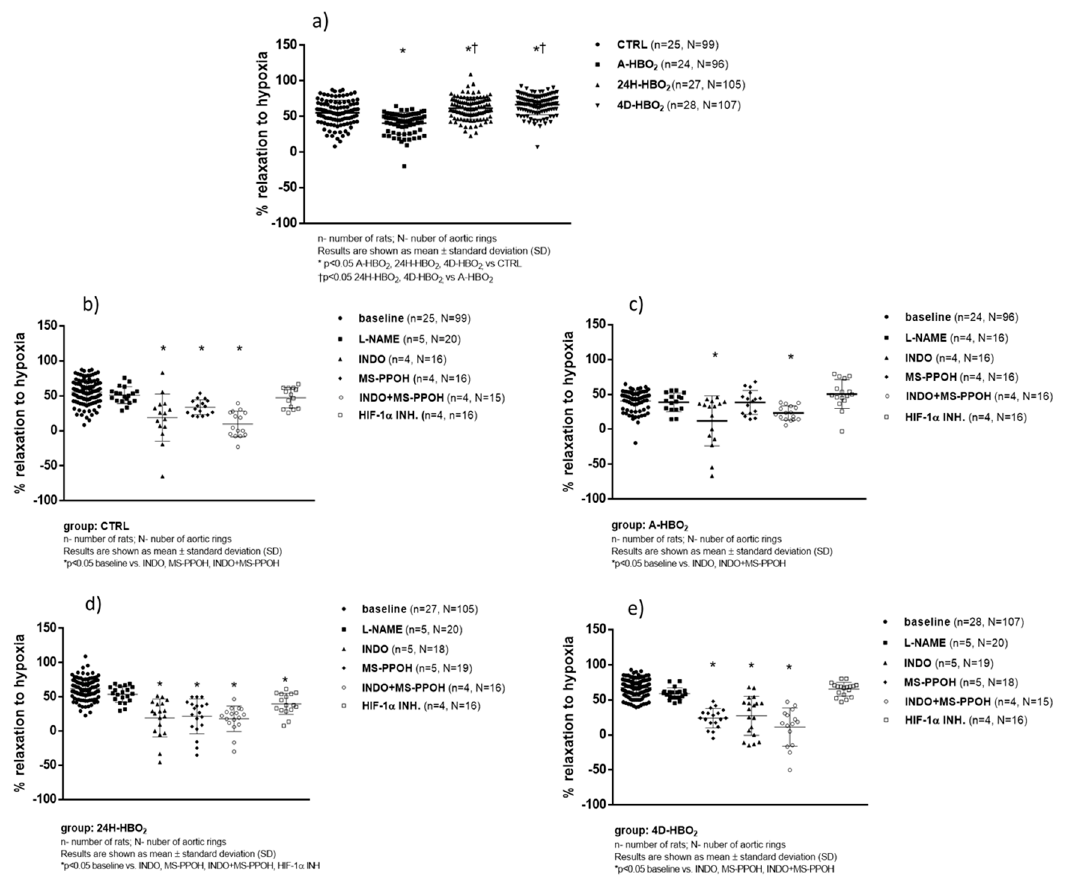
Figure 3. Hypoxia-induced relaxation (HIR) response of isolated rat aorta rings in CTRL ( b ), A-HBO 2 ( c ), 24H-HBO 2 ( d ) and 4D-HBO 2 ( e ) groups without ( a ) and with inhibitors L-NAME, INDO, MS-PPOH, INDO + MS − PPOH and HIF-1 α inhibitor − LW6. Results are presented as mean ± SD; n—number of rats, N—number of aortic rings; * p < 0.05 compared to baseline .